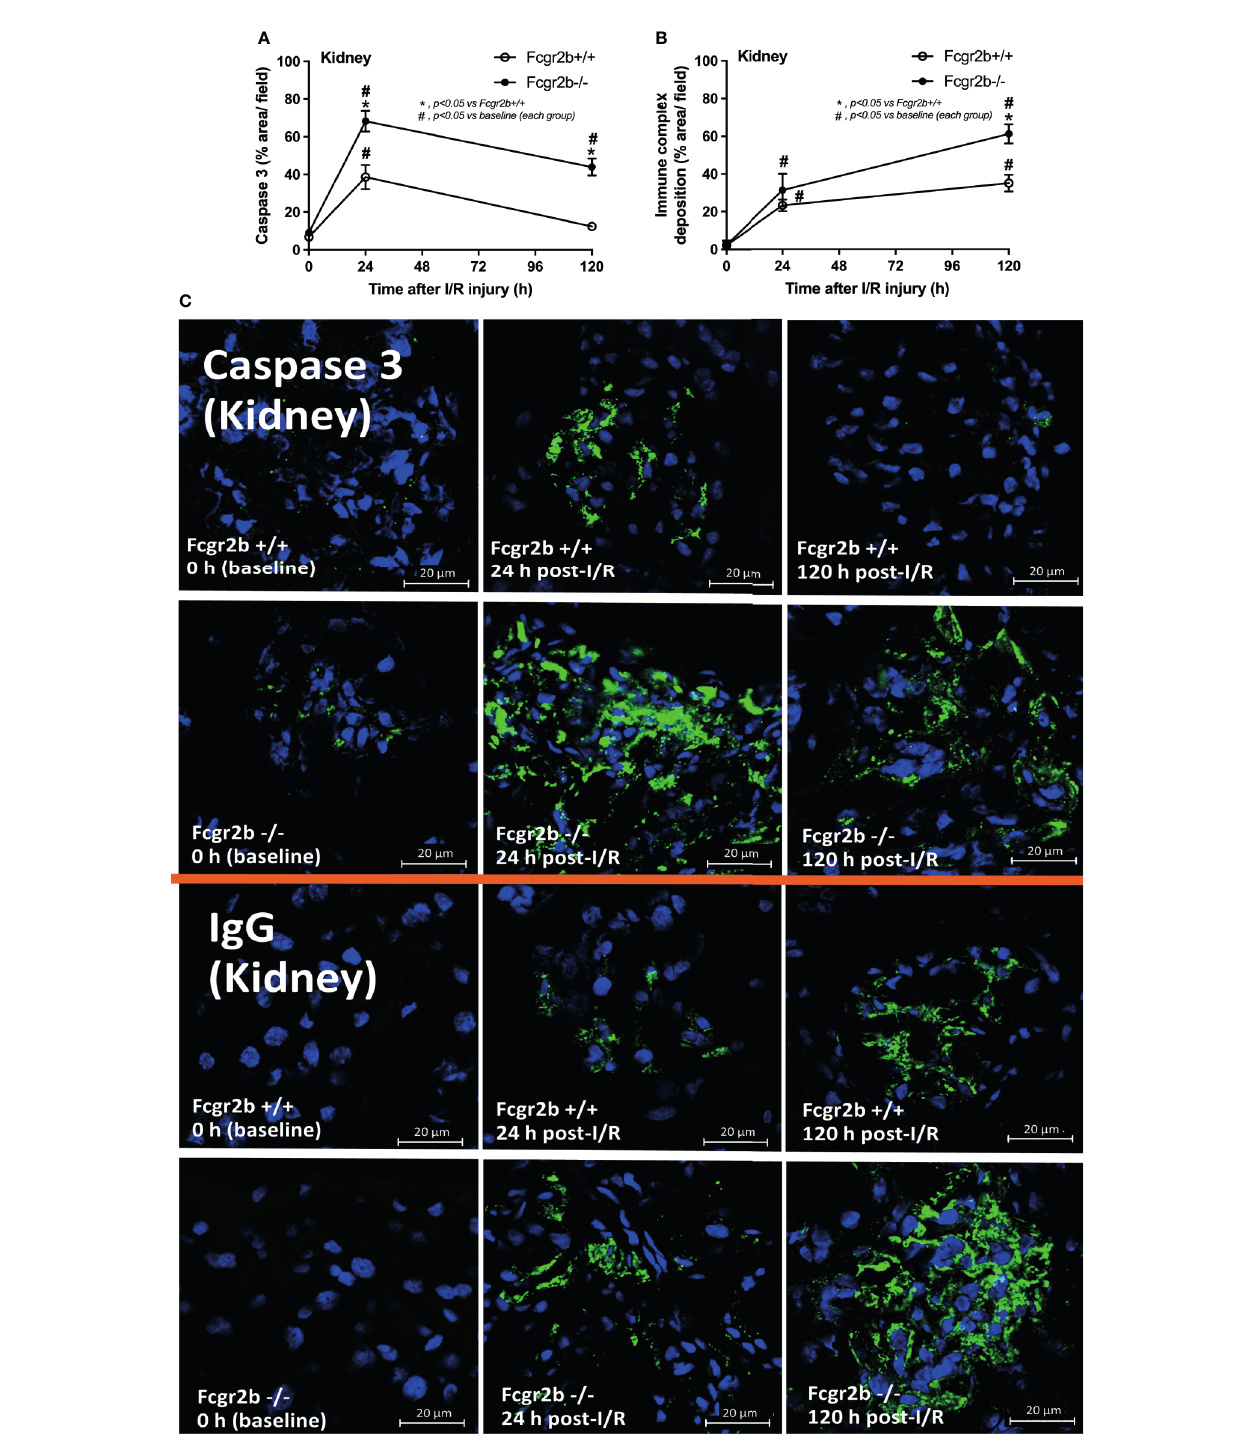
FIGURE 5 | Renal ischemia reperfusion injury (I/R) induced more prominent apoptosis at 24 h post-I/R and immunoglobulin G (IgG) deposition at120 h post-I/R in renal glomeruli of lupus prone mice. Characteristics of renal injury from Fcgr2b-/- or wild-type (Fcgr2b+/+) mice after renal ischemia reperfusion injury (I/R) as evaluated by glomerular apoptosis (activated caspase 3) (A) , glomerular IgG deposition (B) (n = 6 – 7/time-point) with the representative immuno fl uorescent glomerular pictures (activated caspase 3 and IgG deposition) from mice at 0, 24, and 120 h post-I/R (original magni fi cation 630x) (C) are